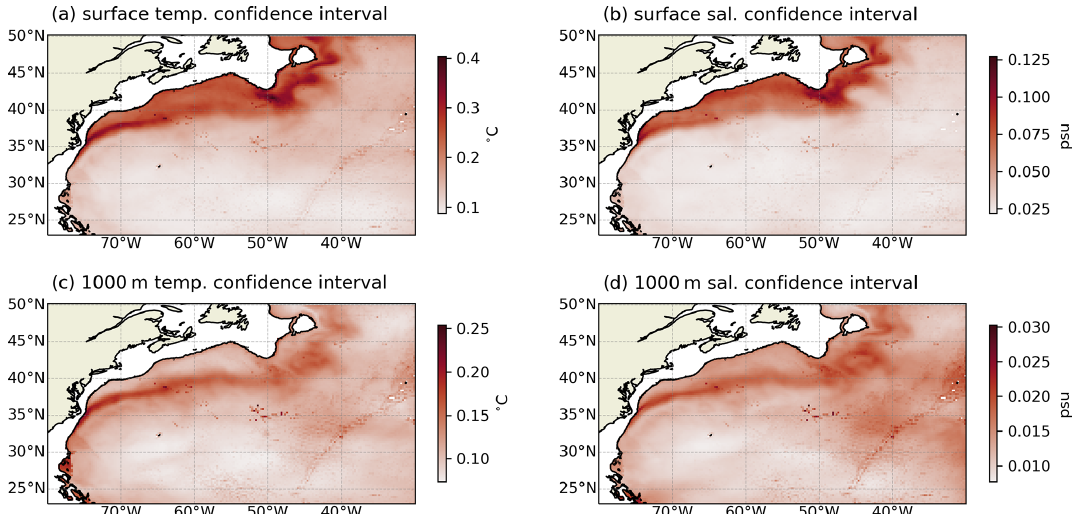
Figure 7. Time average maps of the confidence intervals for surface and 1000m temperature and salinity, i.e., the standard deviation of the 15 bootstrapped models.